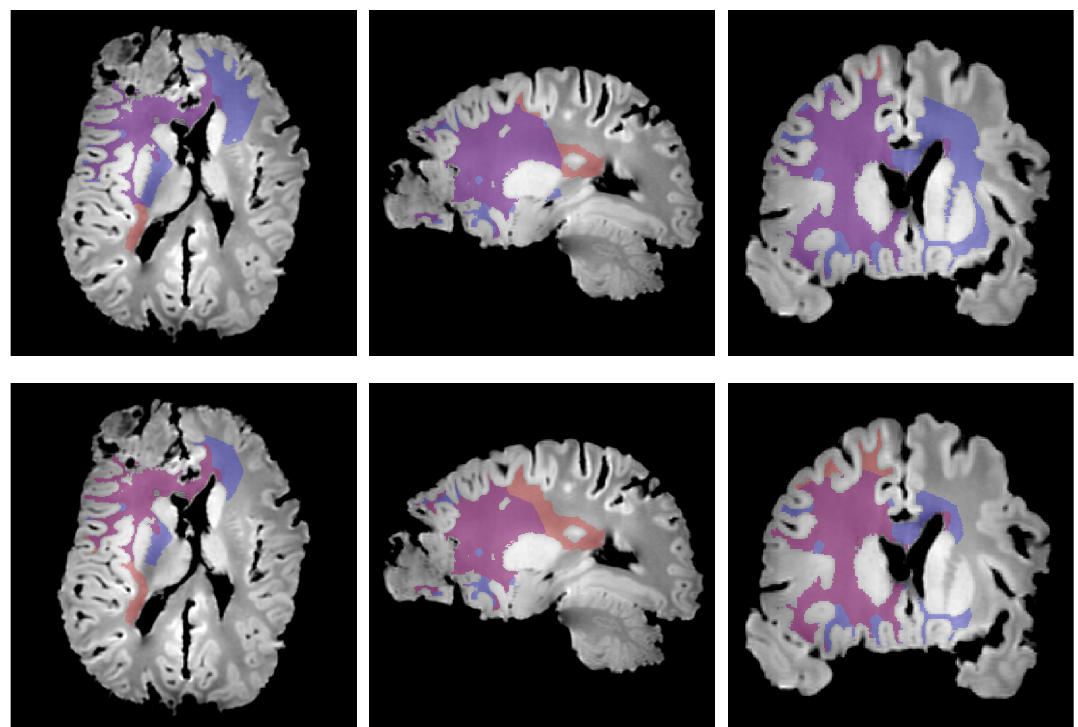
Figure 7. Edema region (red) with superimposed thresholded region of the distance map whose contour minimizes the Hausdorff distance (blue, 1st row ) and average symmetric surface distance (blue, 2nd row ) to the edema contour in axial ( 1st column ), sagittal ( 2nd column ), and coronal ( 3rd column )